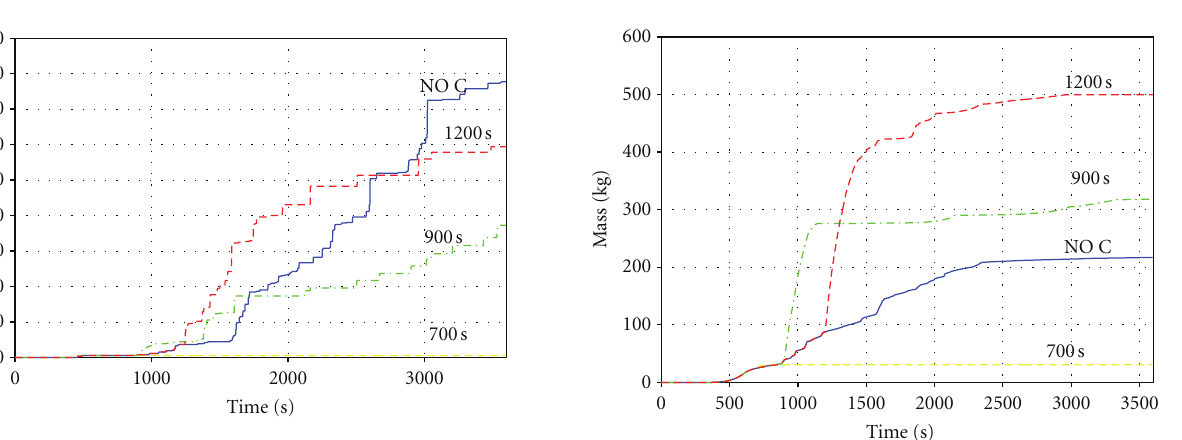
Figure 6: Level of core damage. HPCS injection to 700 s, 900 s, and 1200 s; NO C indicates without HPCS injection.